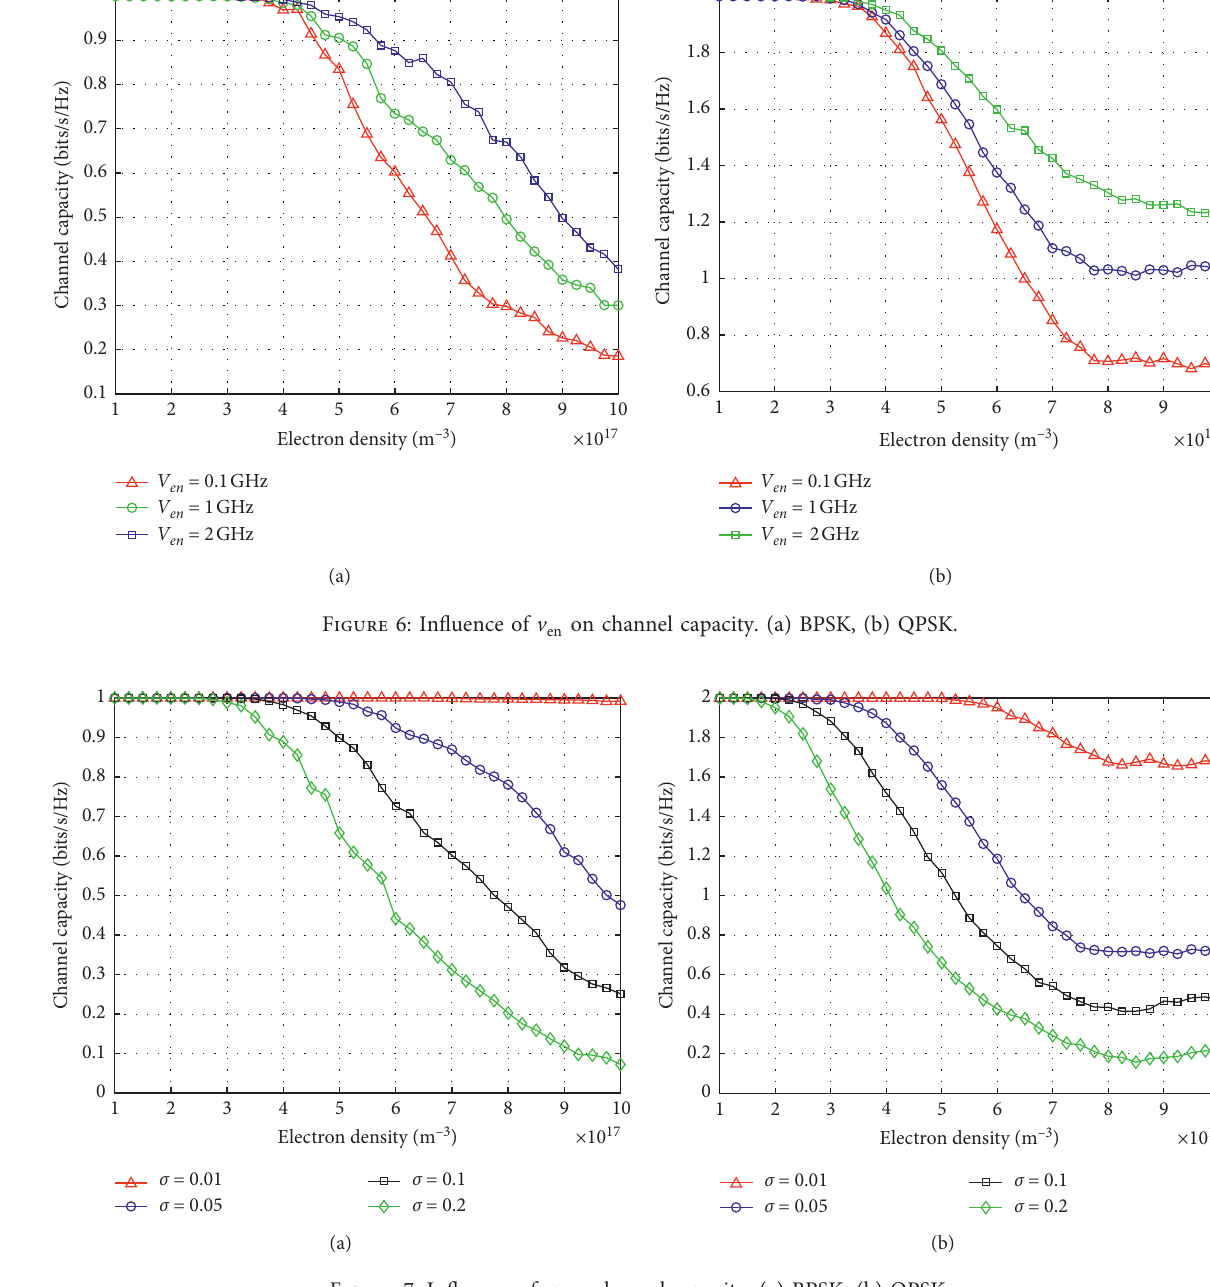
Figure 7: Influence of σ on channel capacity. (a) BPSK, (b)